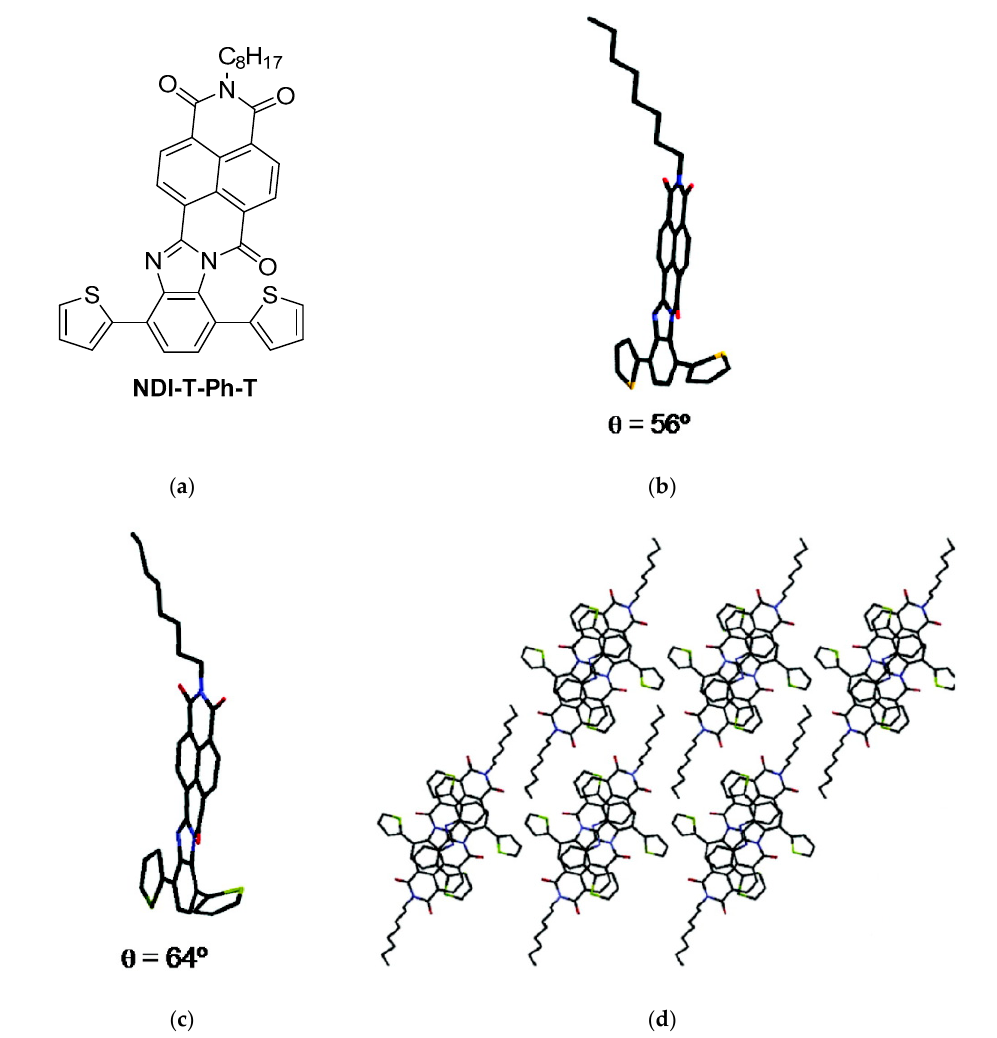
Figure 2. ( a ) Molecular structure of NDI-T-Ph-T. ( b ) Molecular geometry derived from DFT calculations at the B3LYP/6- 31G** level of NDI-T-Ph-T . ( c ) Molecular geometry derived from X-ray diffraction analysis of NDI-T-Ph-T . θ indicates the dihedral angle between the external twisted thiophene and the central benzene plane. ( d ) Molecular structure and packing motif of single crystal of NDI-T-Ph-T , viewed along the b -axis. Adapted with permission from J. Am. Chem. Soc . 2010 , 132 , 24, 8440–8452. Copyright© 2010 American Chemical Society.[12]